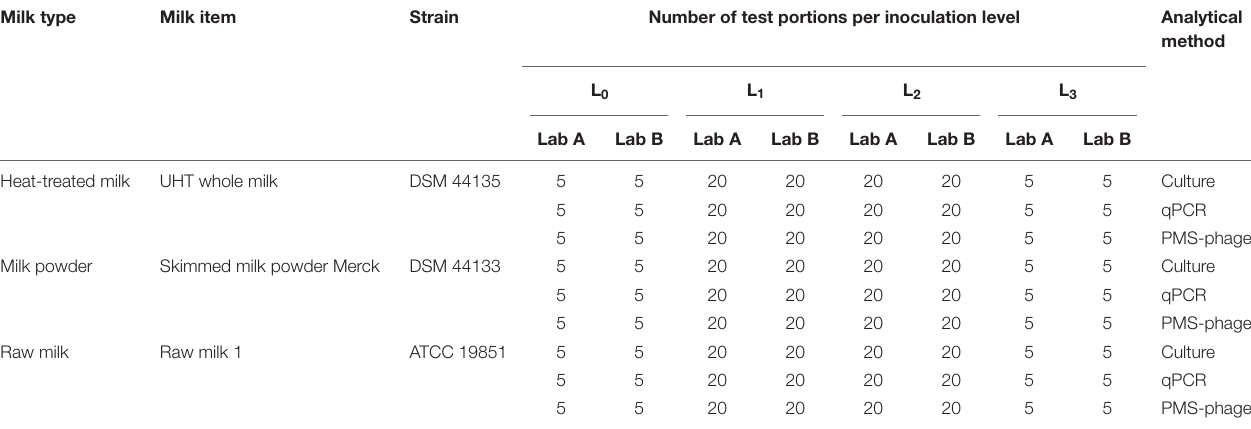
TABLE 2 | LOD study experimental